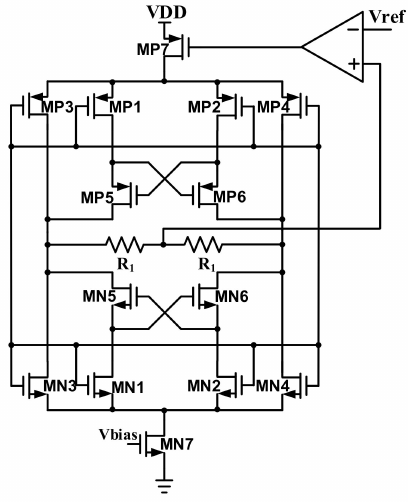
Figure 16. Architecture of the Gm